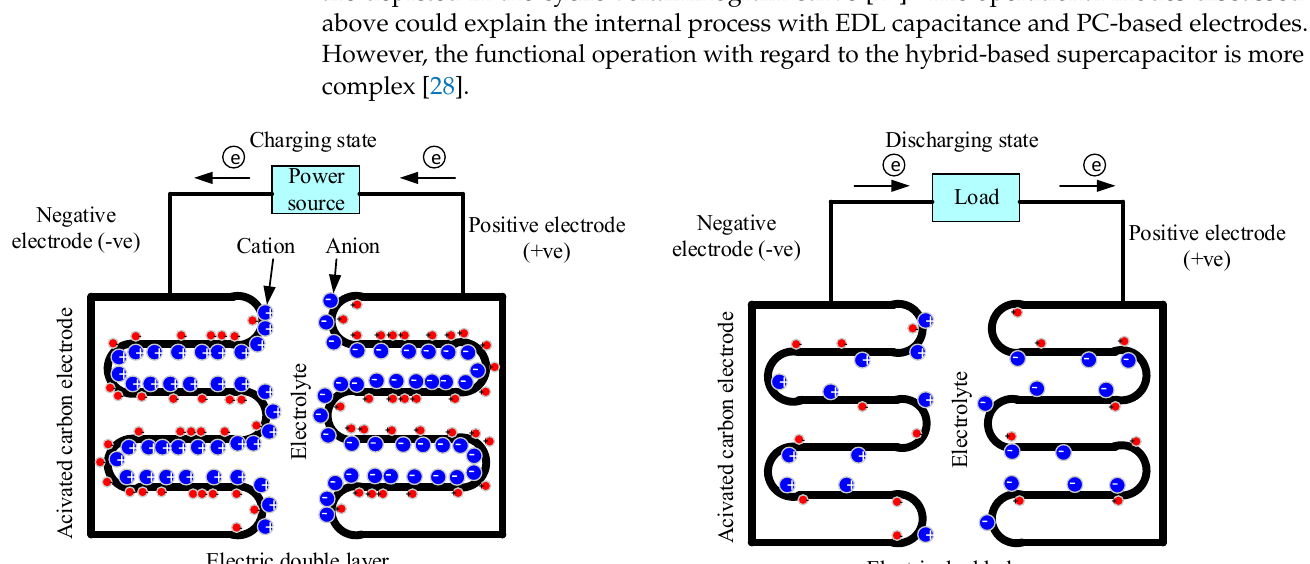
Figure 3. Charging and discharging process in EDL supercapacitor. The Blue colour refers to cation and anion whereas red colour refers to activated carbon electrode ions.